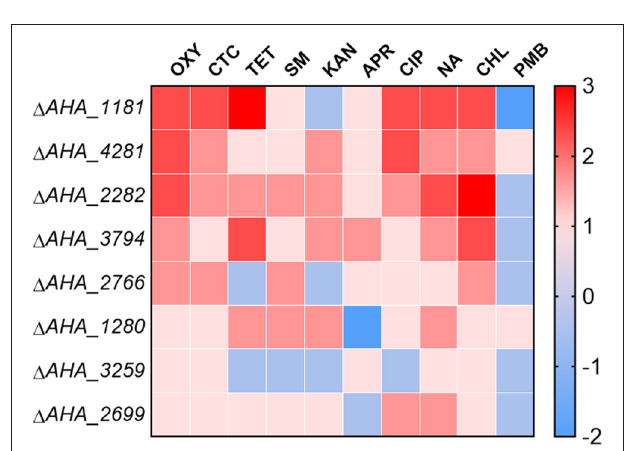
( Figure S3 ) and their base sequences ( File S1 ). These validations indicated that these eight genes were successfully deleted in